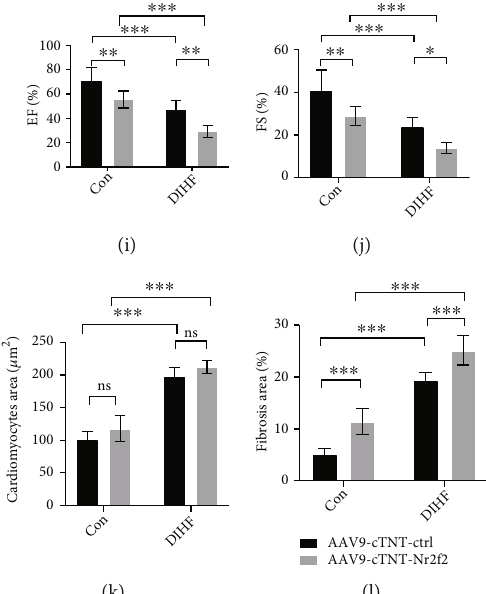
Figure 1: Overexpression of Nr2f2 aggravated the heart failure in diabetic mice. (a) Nr2f2 protein level in DCM mice was quanti fi ed by Western blot ( n = 6 , means ± SDs , ∗∗ p < 0 : 001 , Student ’ t -test). (b) Nr2f2 mRNA level in DCM mice were assessed by real-time qPCR ( n = 6 , means ± SDs , ∗ p < 0 : 05 , Student ’ t -test). (c) The overexpression e ffi ciency of Nr2f2 was quanti fi ed by Western blot ( n = 4 , means ± SDs , ∗ p < 0 : 05 , Student ’ t -test). (d) Fasting blood glucose level of mice at each point (AAV9-cTNT-ctrl-Con, n = 10 vs.